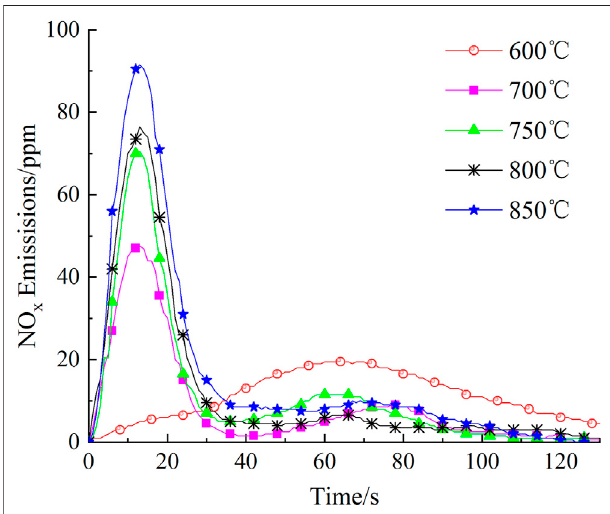
FIGURE 3 | NO x release curves for fast-growing grass combustion at different temperatures.